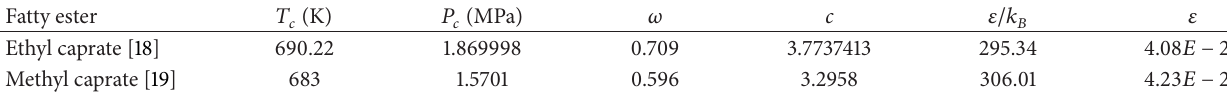
Table 5: Critical properties and parameters of ethyl caprate.